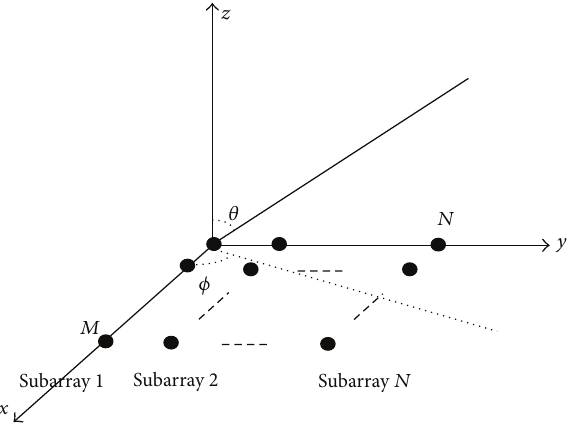
Figure 1: The structure of uniform rectangular array